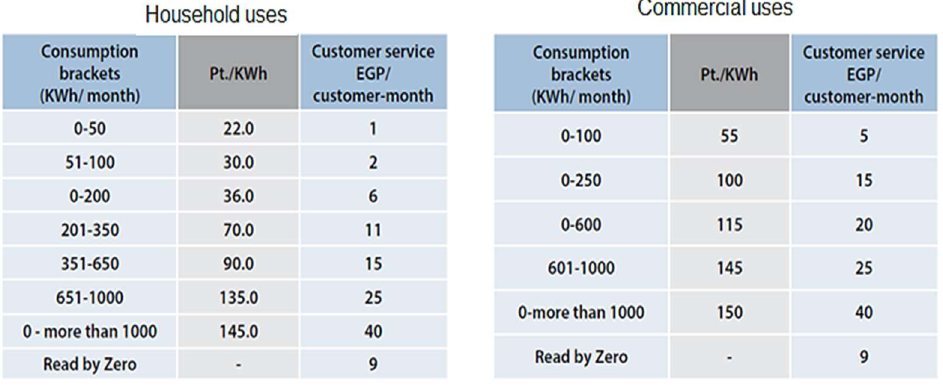
Figure 7. The electricity sales tariff (2017–2018) [72,73].